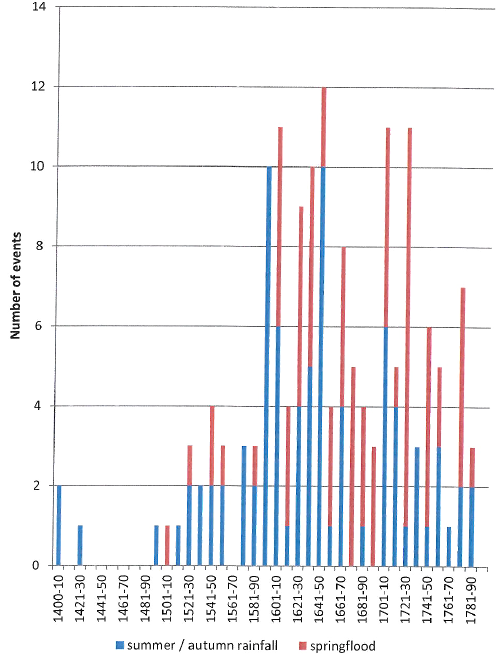
Figure 2. Decadal frequency of floods and extreme rainfall events in Sweden, 1400–1800, according to documentary sources. 1800, of which 107 can be unambiguously defined as floods (see Table A1). Catchments particularly hit by floods were Norrström, Göta älv and Dalälven (see Fig. 1).